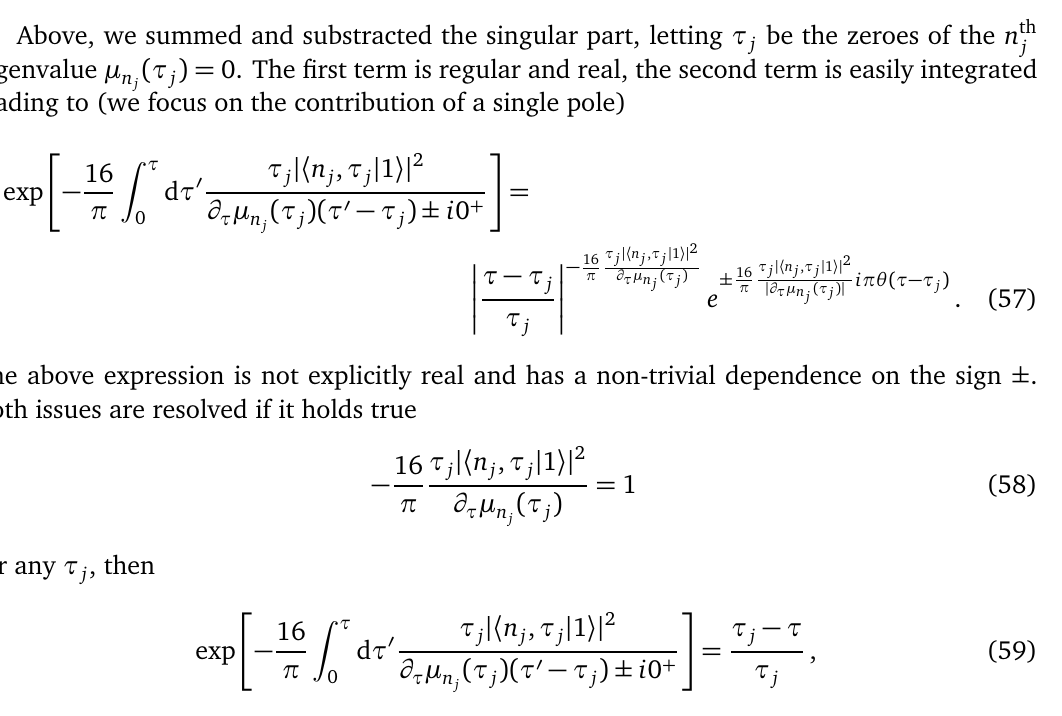
Figure 4: Comparison between probability distribution for the particle number den- sity P ( d ) ≡ (cid:80) ( | φ | 2 = d ) on thermal states computed extracting the root density from TBA equations (37) and using the Transfer Matrix approach. Here β is the inverse temperature characterising the